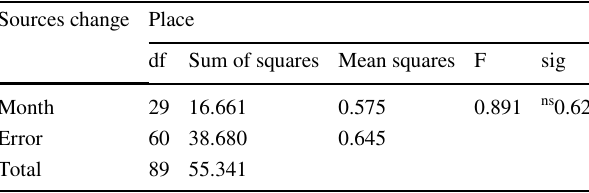
Table 2 The results of the analysis of the variance of lavatory dust between different locations in spring 2015